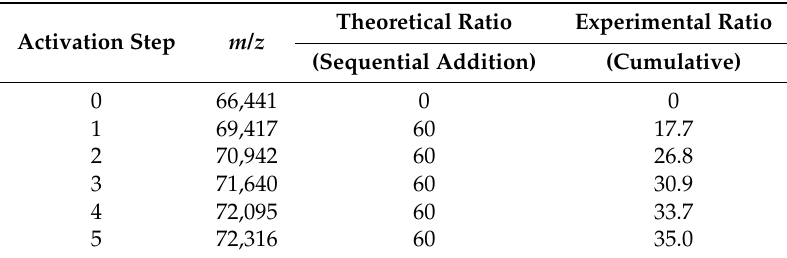
Table 2. Influence of repeated SIA additions to BSA on activation